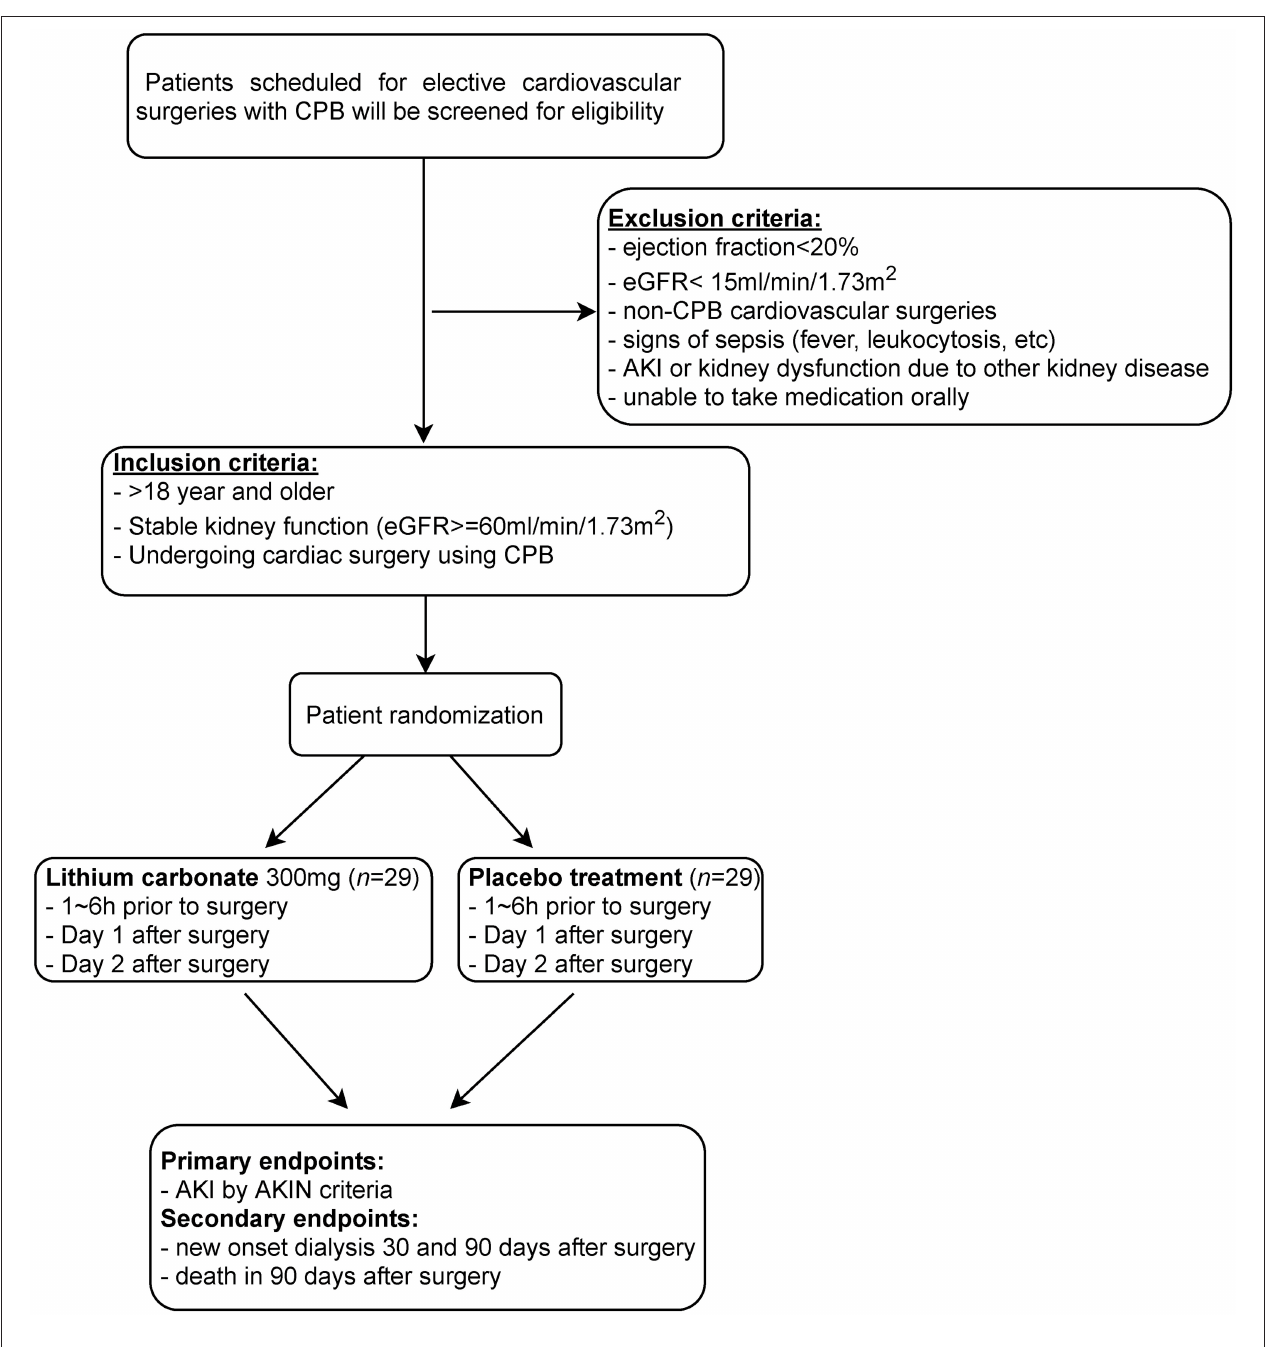
FIGURE 2 | Flow diagram depicting the design of this single center, randomized, double blinded, placebo controlled pilot trial. Patients scheduled to undergo cardiovascular surgeries with cardiopulmonary bypass (CPB) will be subjected to eligibility assessment for inclusion in this trial to test the potential of short-term use of microdose lithium for protecting against CSA-AKI. This will include patients in the emergency department, general floors, critical care units, coronary care unit and step down/ telemetry units.